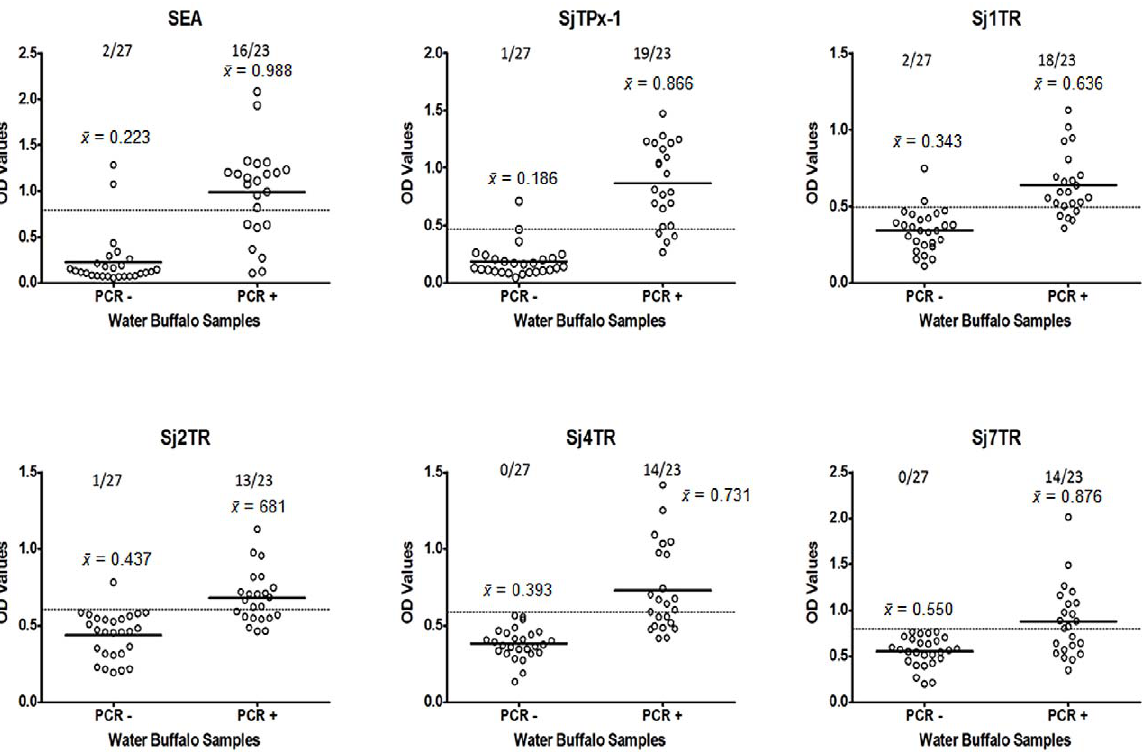
Figure 2. Difference in OD values among stool PCR negative and positive in ELISA using SEA and the recombinant proteins. The graph shows that SjTPx-1 and Sj1TR have the highest number of positives among the PCR positive samples. PCR negative samples that are positive for ELISA using the recombinant proteins show OD values minimally higher than the cut-off values. Mean OD values for each set were also shown.